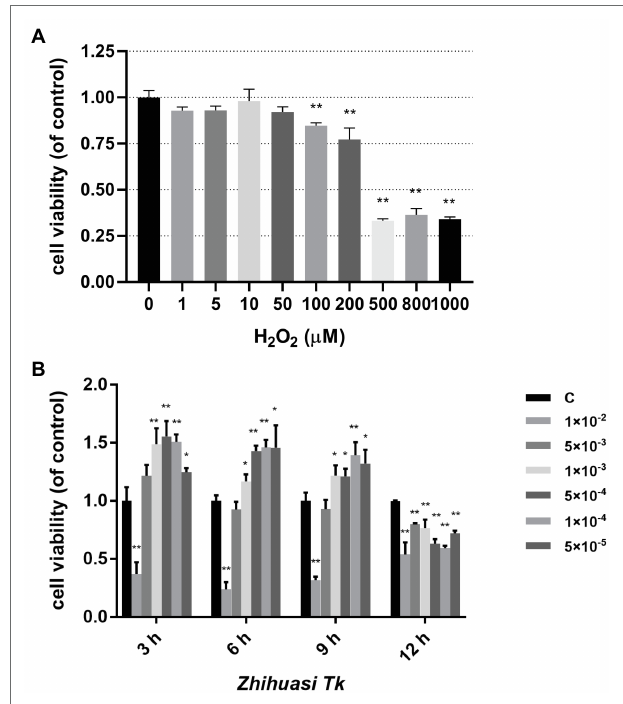
FIGURE 1 | Effects of H 2 O 2 (A) and Z. Tk (B) of different concentrations on the viability of IPEC-J2 cells treated with different times. Symbols “*” and “**” indicate the significant differences compared with the control group set at the values of p of 0.05 and 0.01,